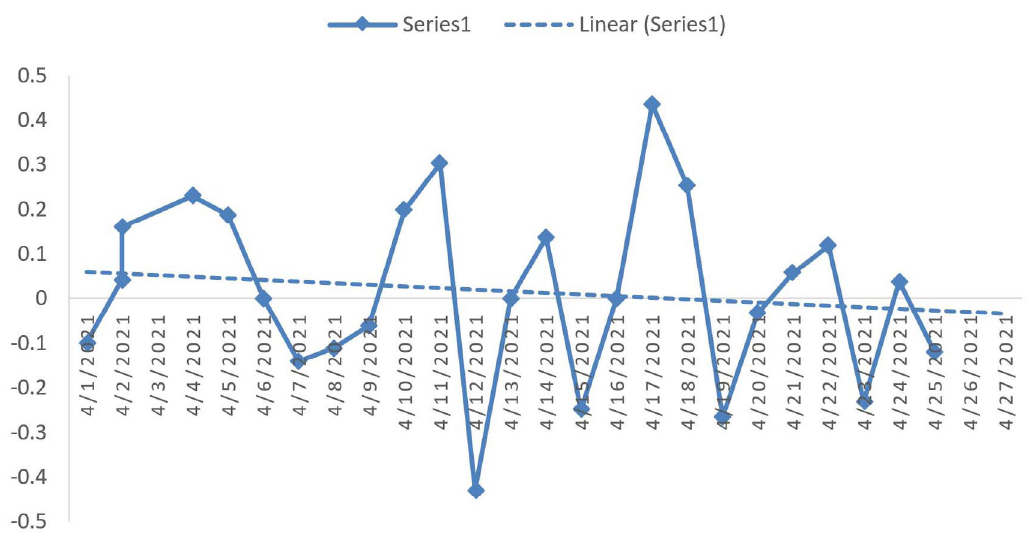
Fig. 5. The COVID-19 growth rate over a period of 25 days from the 1st to the 25th of April